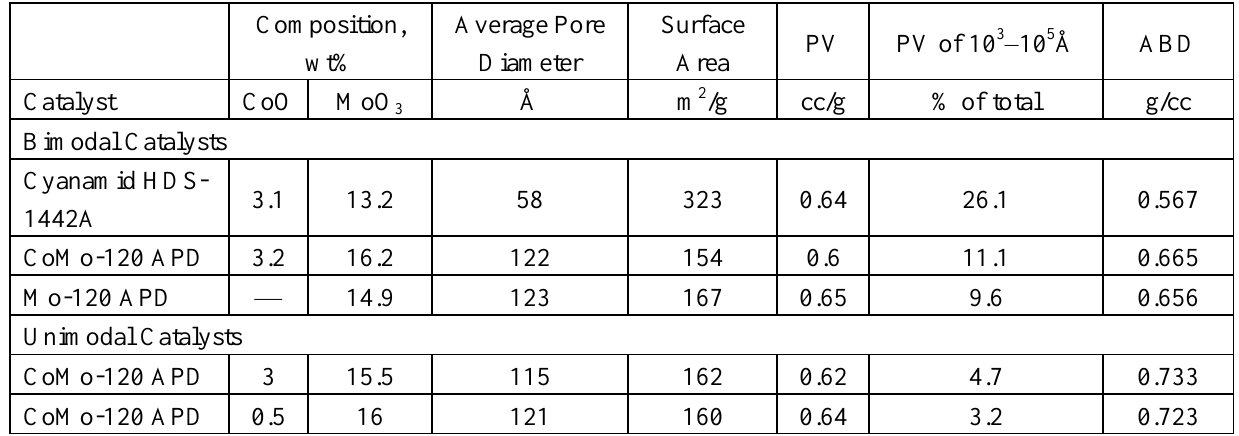
Table 4. Catalyst inspection data for coal liquefaction